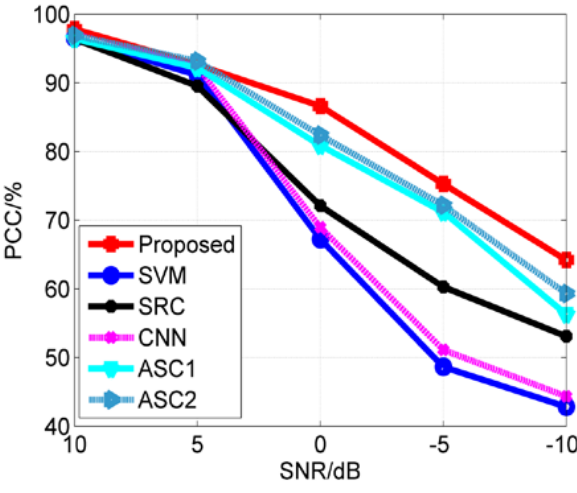
Figure 11. Performance of different methods under noise corruption.